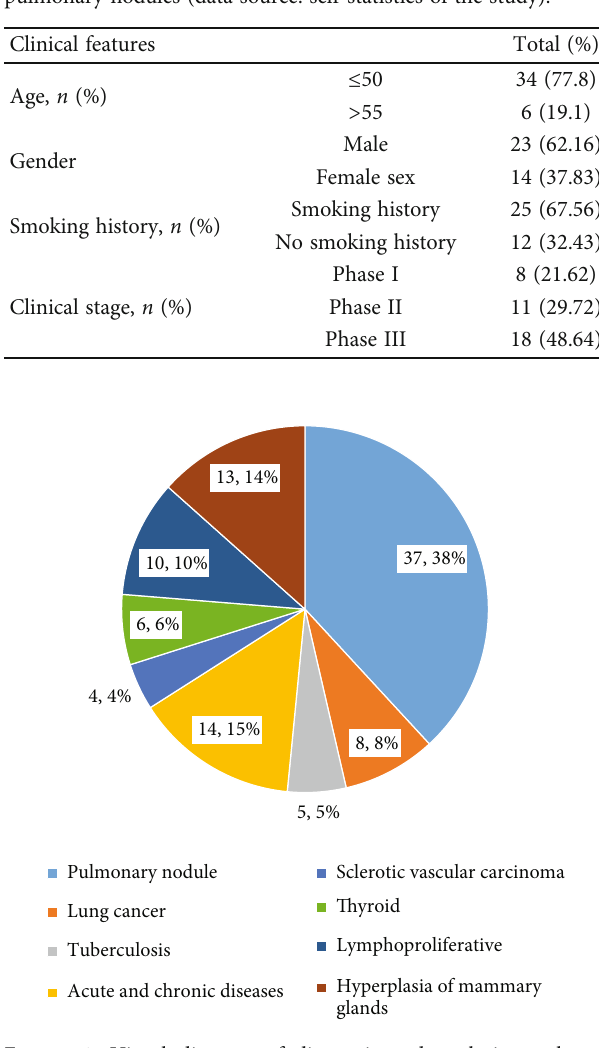
Figure 1: Visual diagram of diagnosis and analysis results of patients with pulmonary